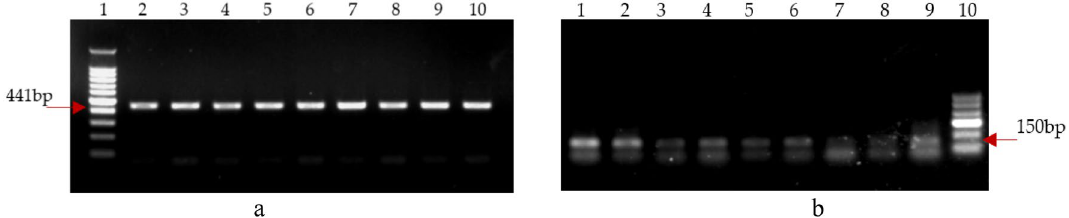
Figure 4. PCR amplification of genomic DNA extracted from different plant parts of B. bassiana and M. anisopliae treated Zea mays ( a ) Bb13; Lanes 1, 100 bp—1 kb DNA ladder; Lane 2–4, DNA from Zea mays root; Lane 5–7, DNA from Zea mays steam; Lane 8–10, DNA from Zea mays leaf. ( b ) Ma73; Lanes 10, 100— 600 bp DNA ladder; Lane 1–3, DNA from Zea mays root; Lane 4–6, DNA from Zea mays steam; Lane 7–9, DNA from Zea mays leaf. Recovery rate of M. Recovery rate of B. anisopliae (%) bassiana (%) Days